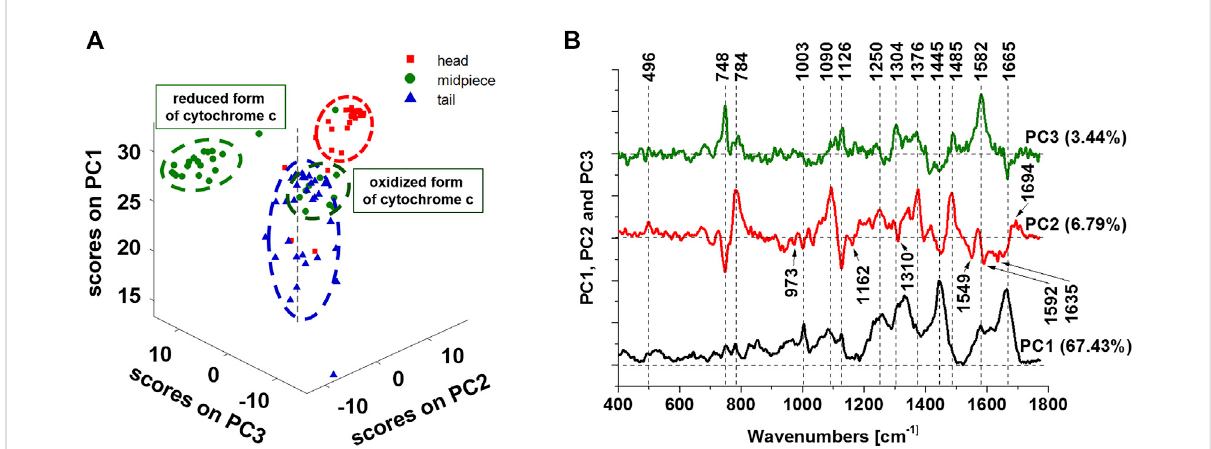
FIGURE 4 Principal components analysis of Raman data. The scatter plot of the score values of Raman spectra for the fi rst, second and third principal components (PCs) from the head (red squares), midpiece (green circles) and tail (blue triangles) of sperm (A) . The loadings plots of PC1, PC2 and PC3 (B) . Data was acquired at 532 nm with 0.5 s integration time and 10 accumulations per single spectrum. The total number of 90 line scanned Raman spectra from the sperm cells were analyzed. Preprocessing PCA mode: SNV